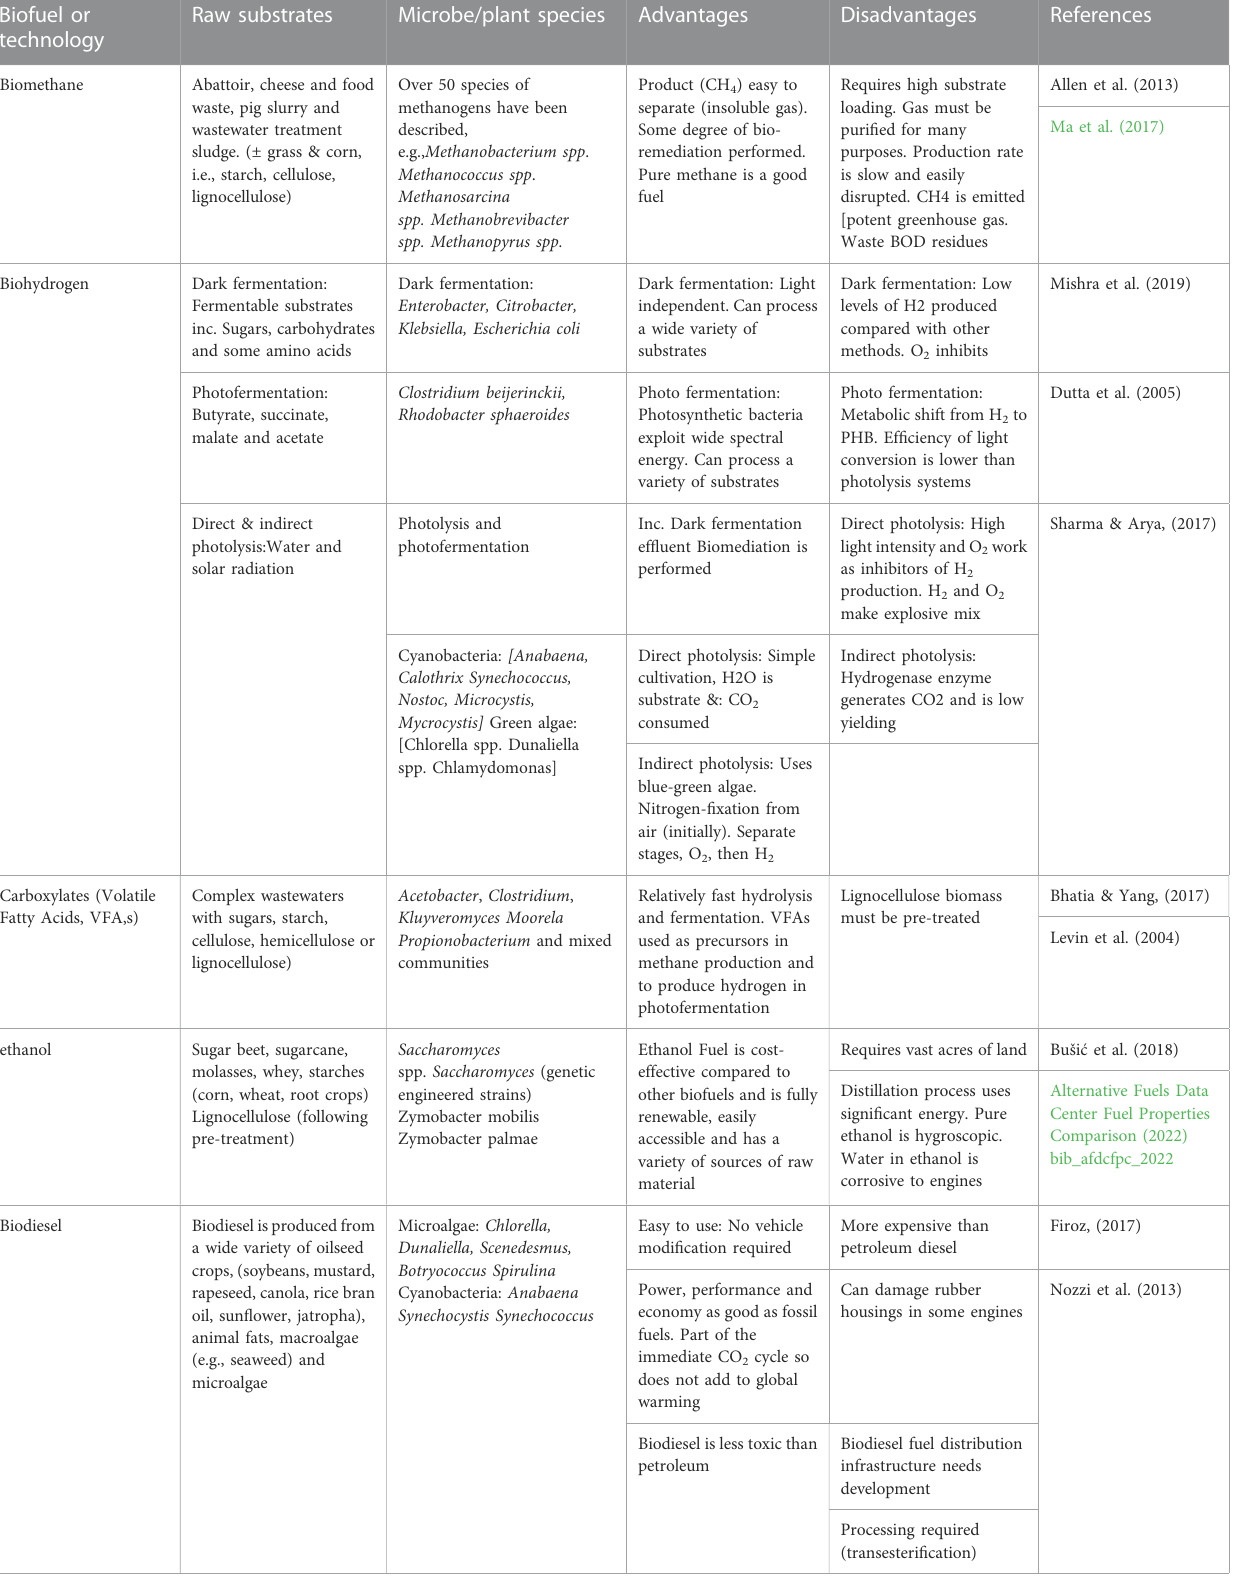
TABLE 4 Comparison between different types of biofuel and biotechnology. Biofuel or